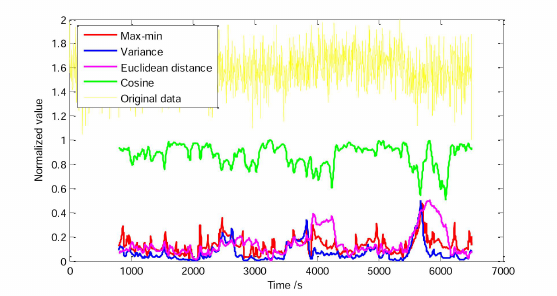
Figure 18. False Positive in PU anomaly detection.